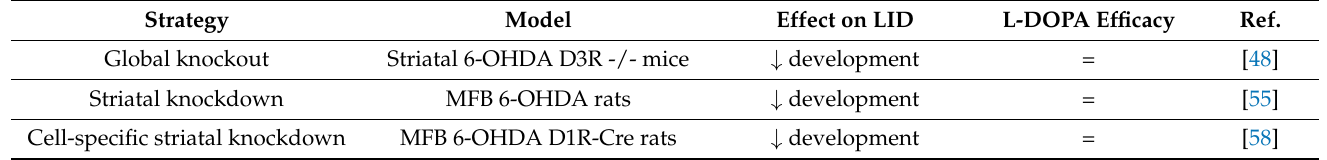
Table 2. Non-pharmacologic strategies to target